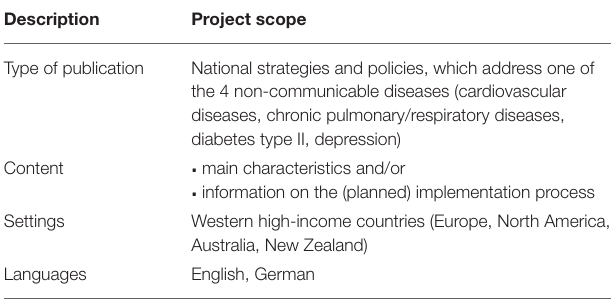
TABLE 1 | Inclusion criteria for relevant national